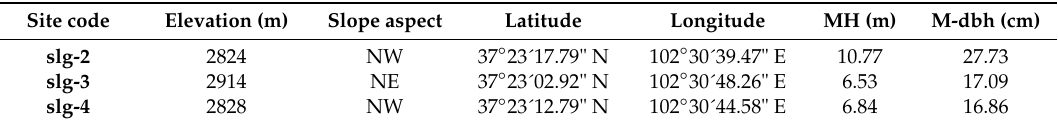
Table 1. Site information for four sampling